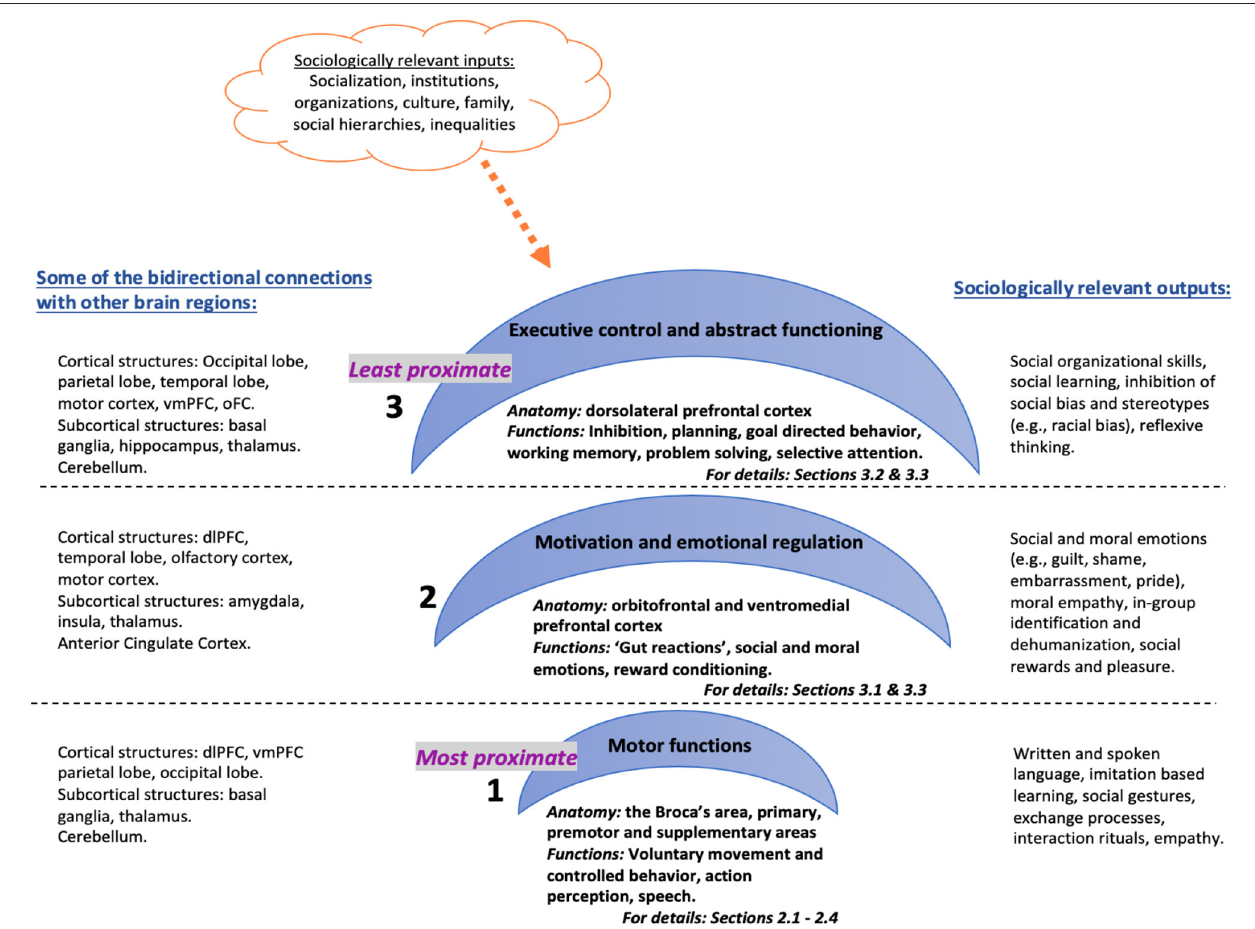
FIGURE 1 | Three inter-related hierarchical systems with varying degrees of causal proximity in regulating human behavior and